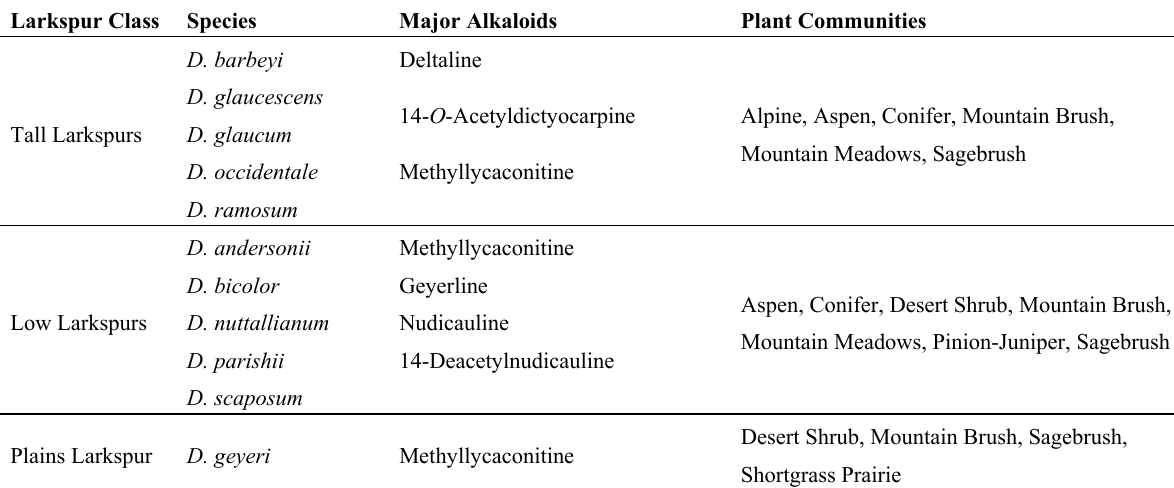
Figure 2. Distribution map of the major tall larkspur species in the western United States. Table 1. Larkspur classes and major species causing livestock losses associated with each class, with associated plant communities and possible dominant